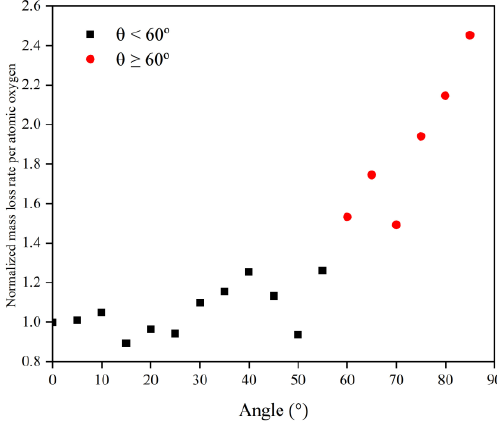
Figure 13. Mass loss rate of the Kapton caused by atomic oxygen at different incident angles.